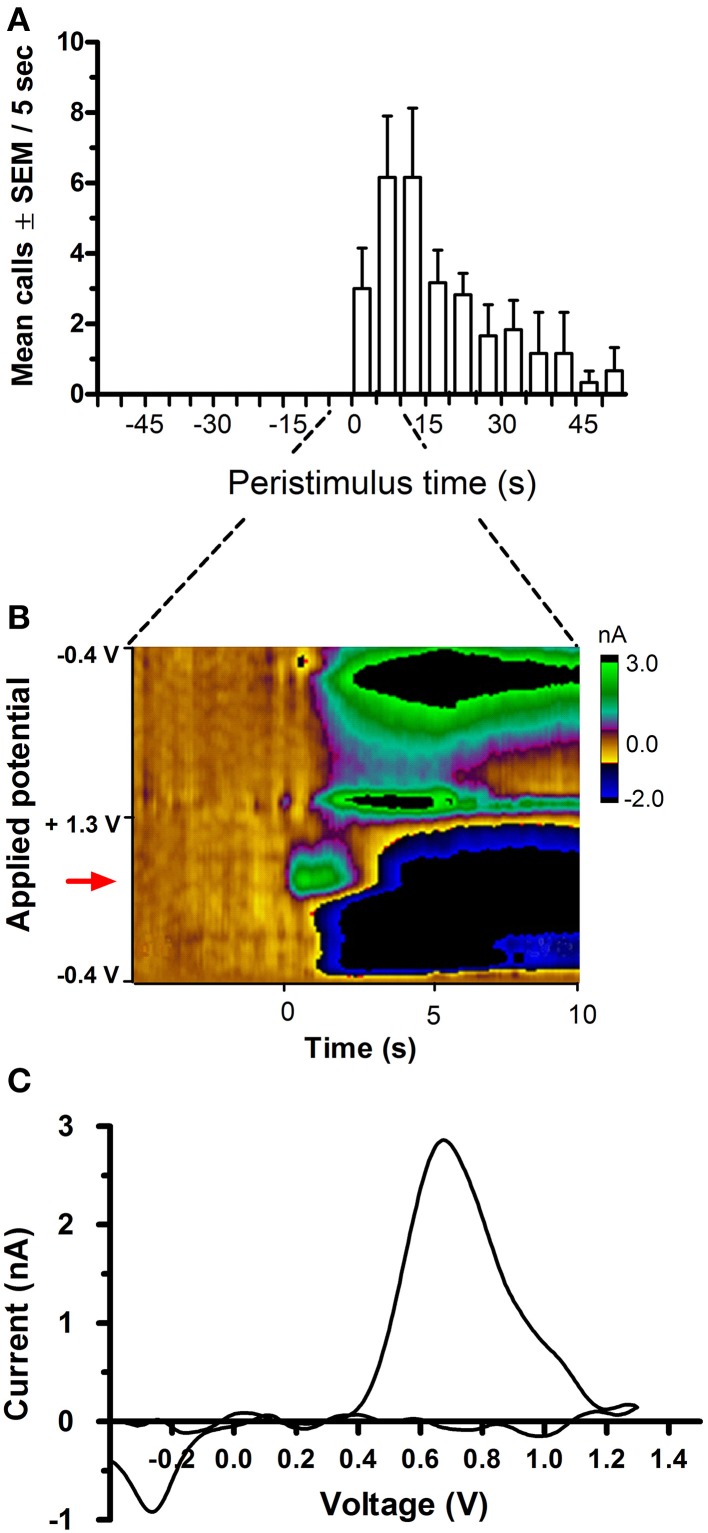
Time course of 50-kHz call emission and phasic DA release following electrical stimulation of the medial forebrain bundle (MFB). Stimulated DA release in the nucleus accumbens (NAcc) was timed-locked to MFB stimulation (24 biphasic 120 μA 60 Hz pulses, each pulse comprising a pair of 2-ms phases) and the onset of USV emission. (A) shows an increase in call rate following MFB stimulation. The 1-s stimulation started at 0 s. (B) is a false-color plot from a representative rat, showing changes in DA current (green color) in relation to applied potential (y-axis) and time (x-axis), with onset of MFB stimulation occurring at t = 0 s, at the oxidation potential of dopamine (red arrow), i.e., ~0.65 V (vs. Ag/AgCl reference). (C) shows the corresponding background-subtracted cyclic voltammogram from the same rat at the point of peak DA current seen in (B).